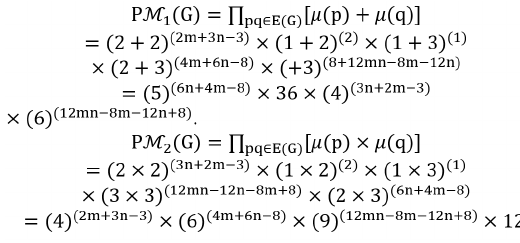
Table 2: Edge partitions.